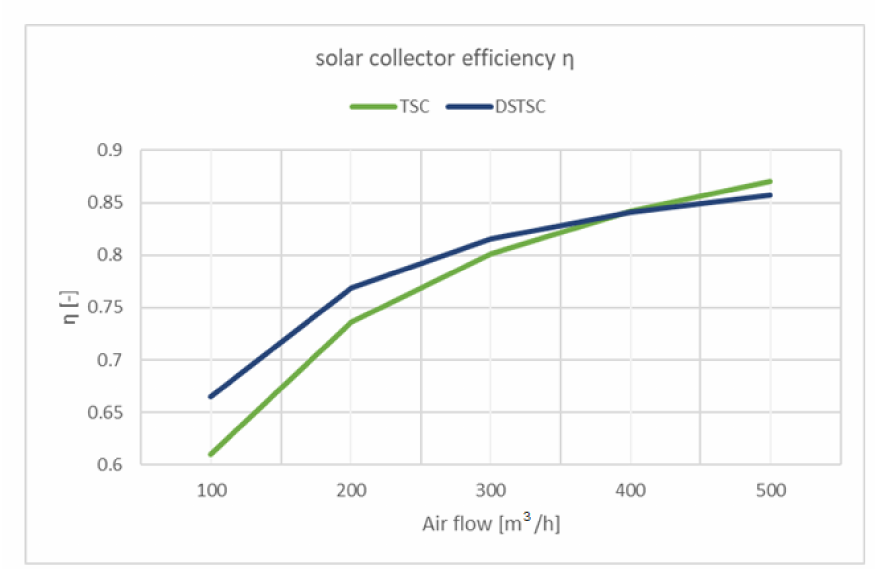
Figure 7. Solar Collector efficiency.